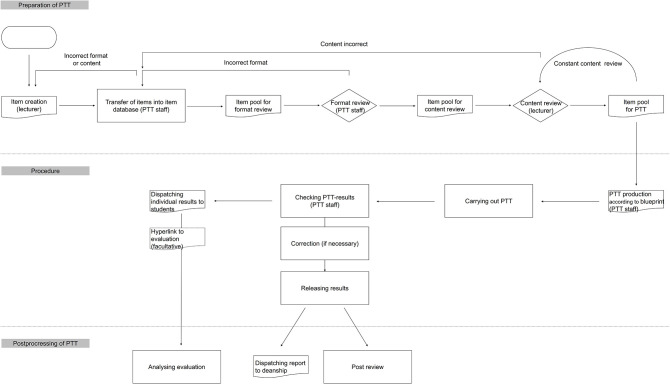
PTT workflow (Progress test veterinary medicine of the German-speaking countries).